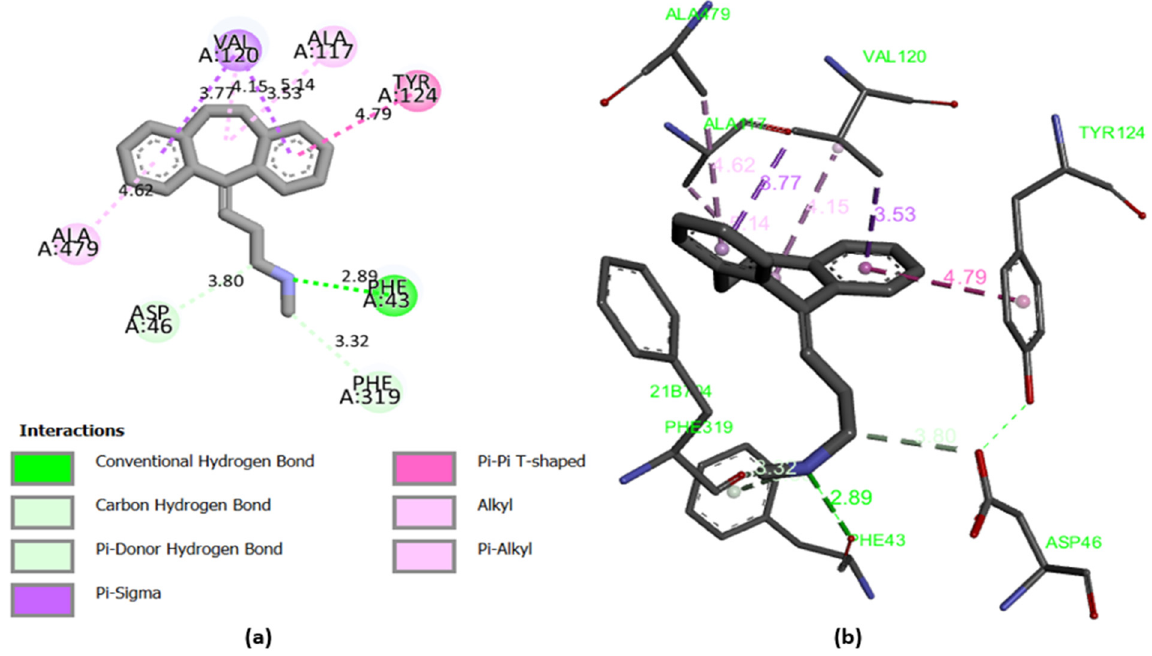
Figure 10. 2D ( a ) and 3D ( b ) visualization of intermolecular interaction between the docked nortrip- tyline and the protein target (binding energy of − 9.11 kcal/mol).